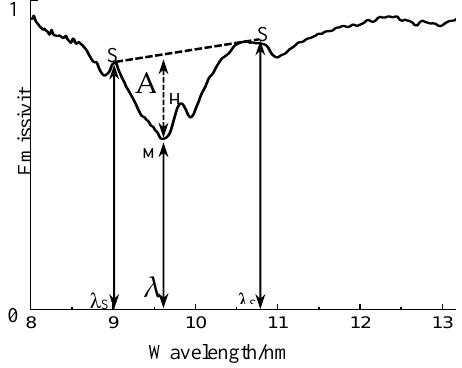
Figure 8. Diagram of thermal infrared spectra of carbonaceous gangue samples.